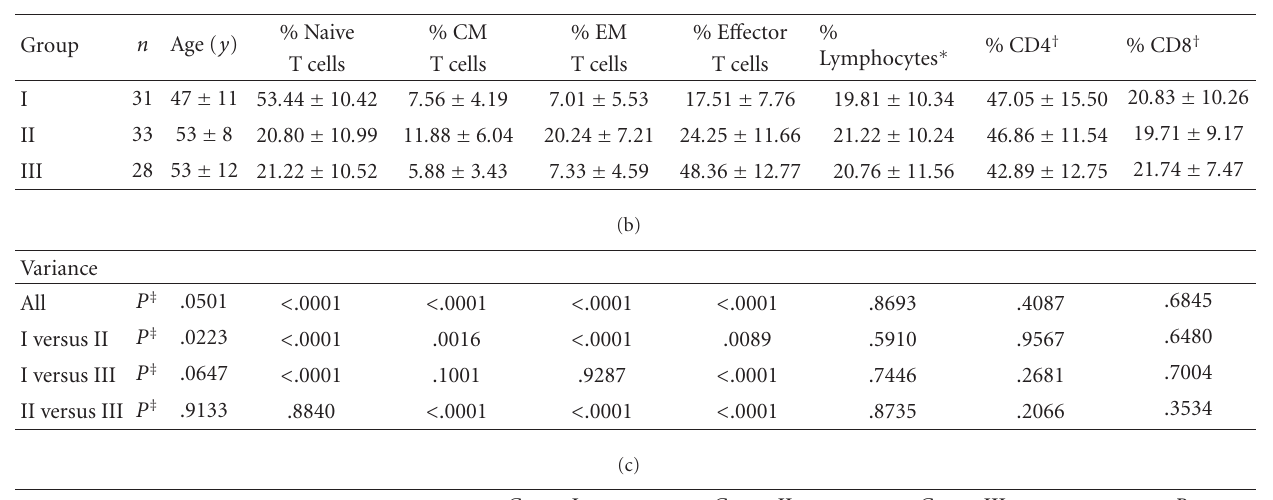
Table 1: Hierarchical clustering in 3